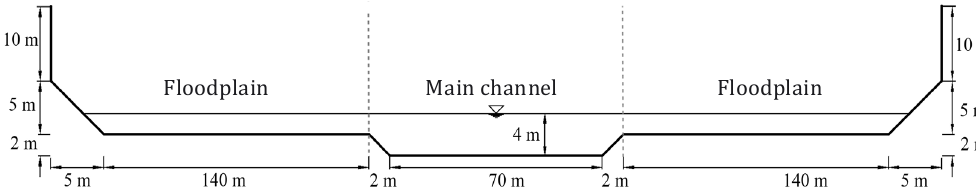
Figure 9. Cross-section view of the compound channel